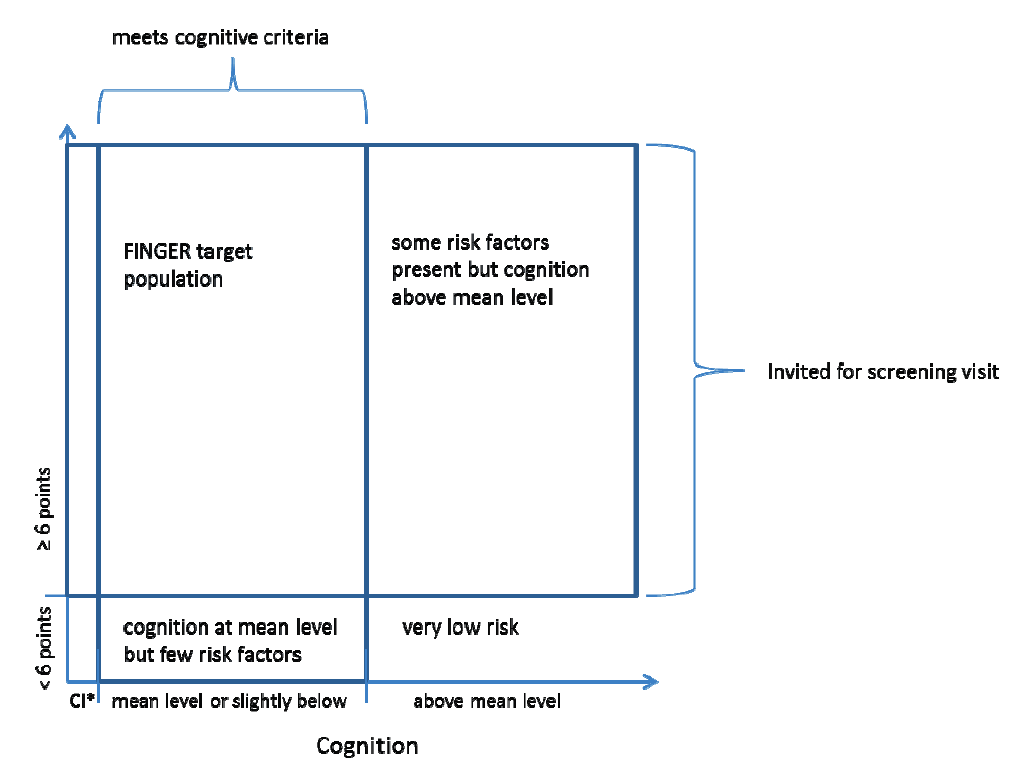
Figure 1. FINGER inclusion criteria and target